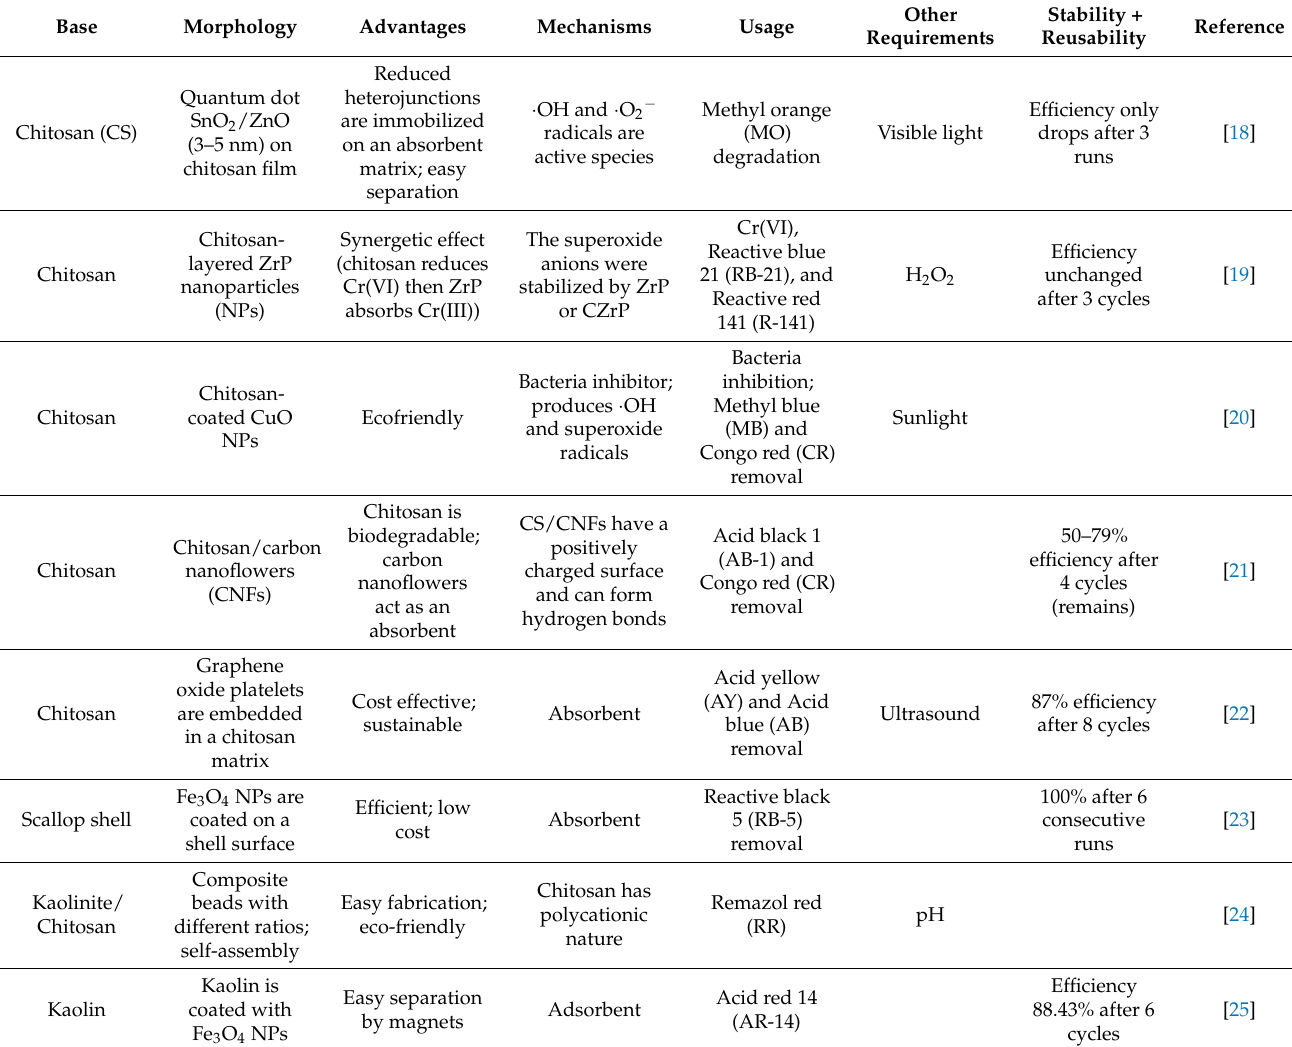
Table 1. Nanocomposite photocatalysts based on natural